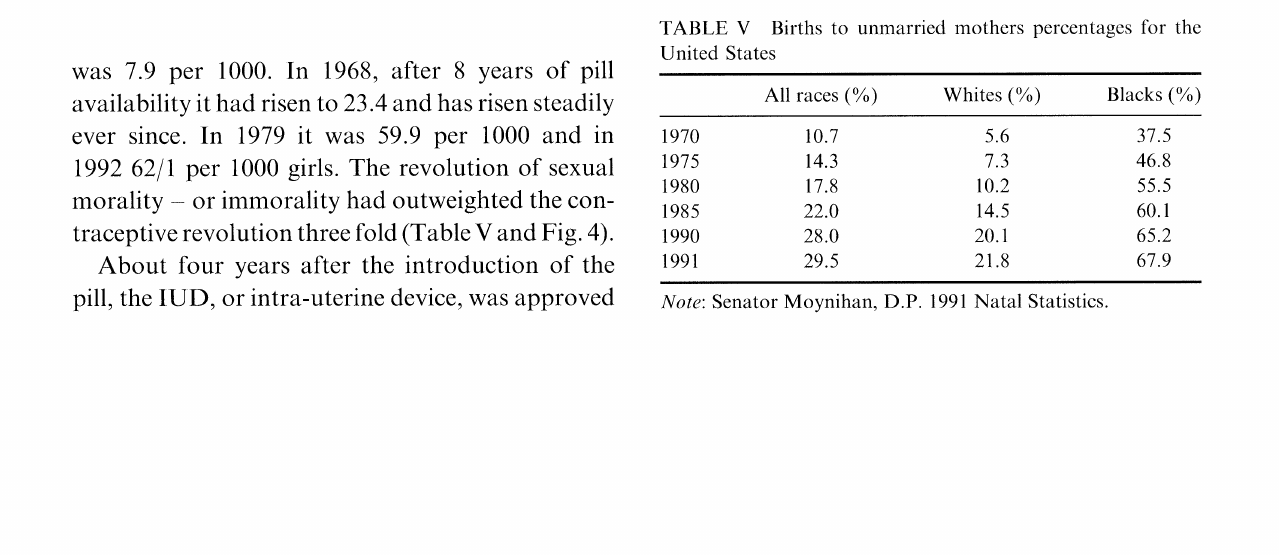
FIGURE 3 Patterns of contraceptive use in different regions.